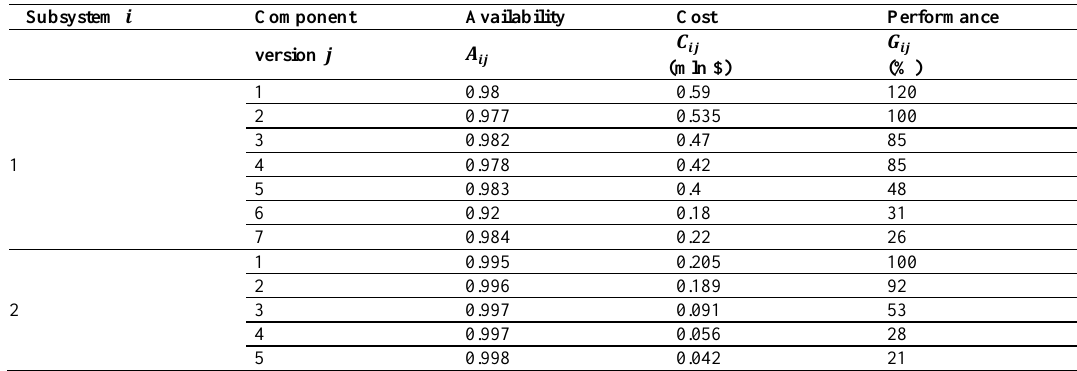
Table 14. Data of the components available in the market (Example